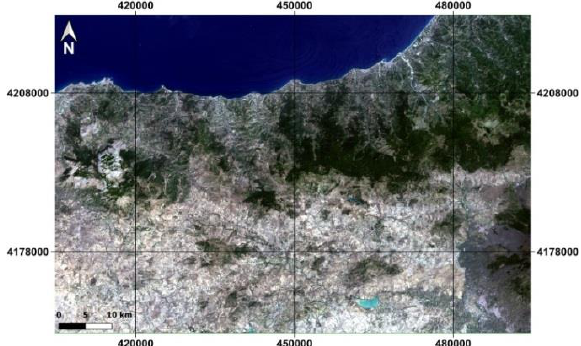
Figure 2. RGB true colour composition of the Landsat 8 OLI images, in UTM-WGS84 plane coordinate.